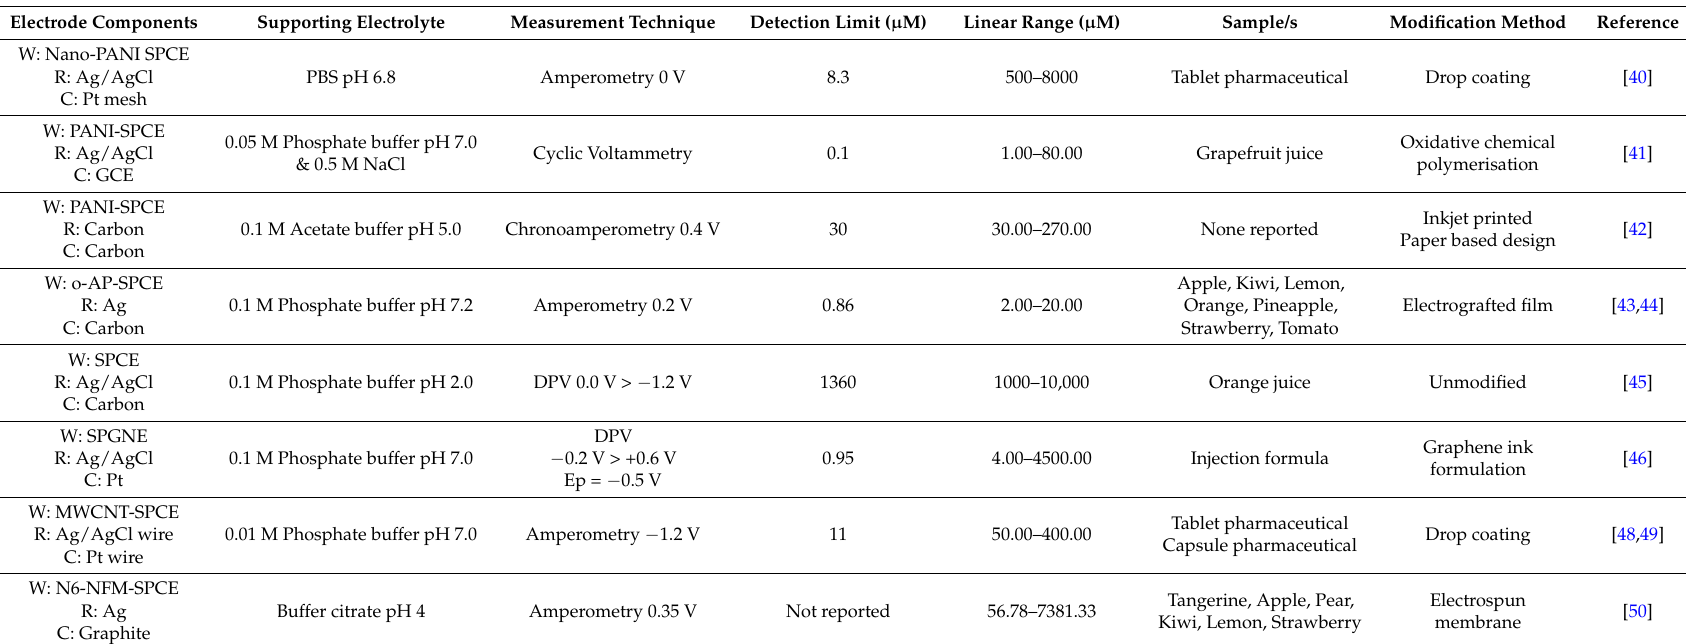
Table 5. Reports of screen-printed sensors for vitamin C (L-ascorbic